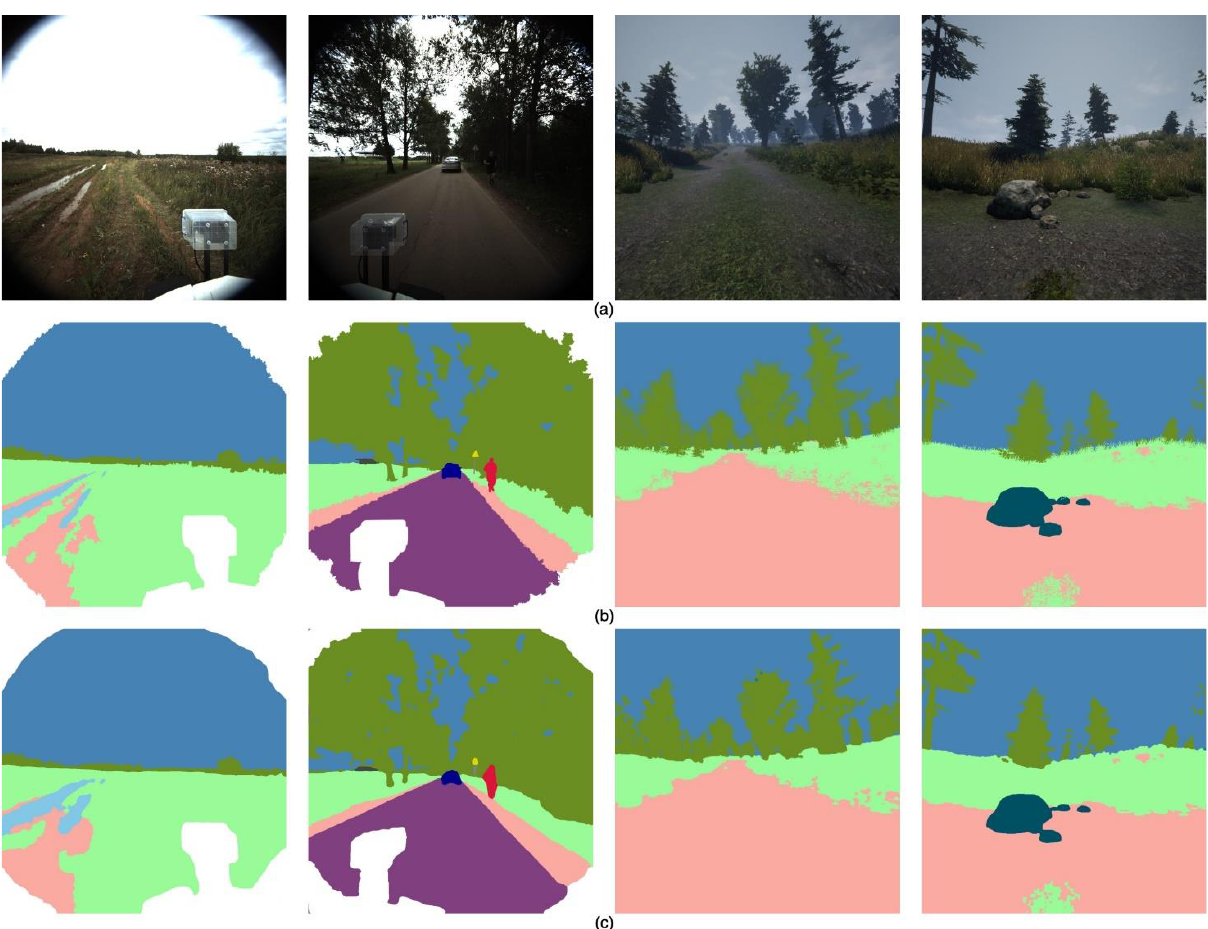
Figure 3. Input images from our off-road datasets (a), ground-truth images for our datasets (b), result images of the proposed approach (c)